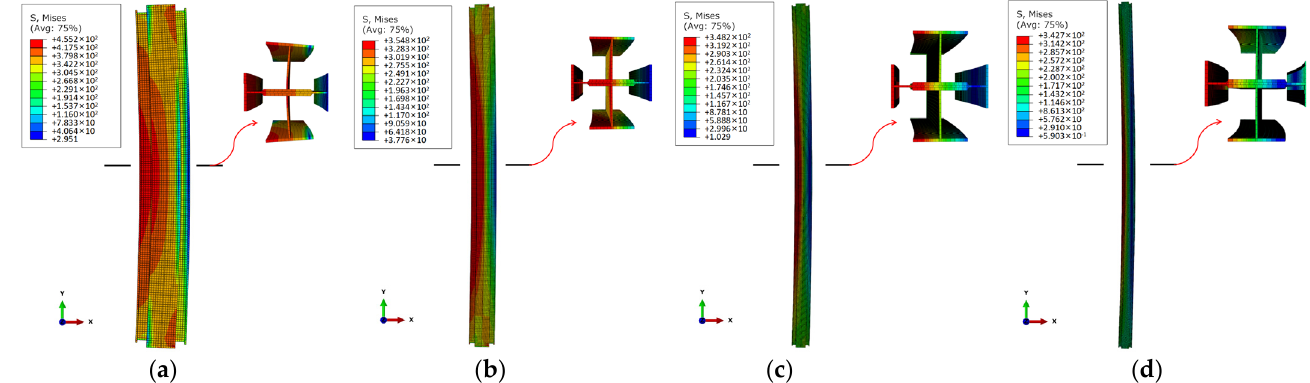
Figure 7. The FCHC-1-3 series illustrates the typical failure mode of the flexural-torsional buckling: ( a ) FCHC-1-3-3; ( b ) FCHC-1-3-6; ( c ) FCHC-1-3-9; ( d ) FCHC-1-3-12.